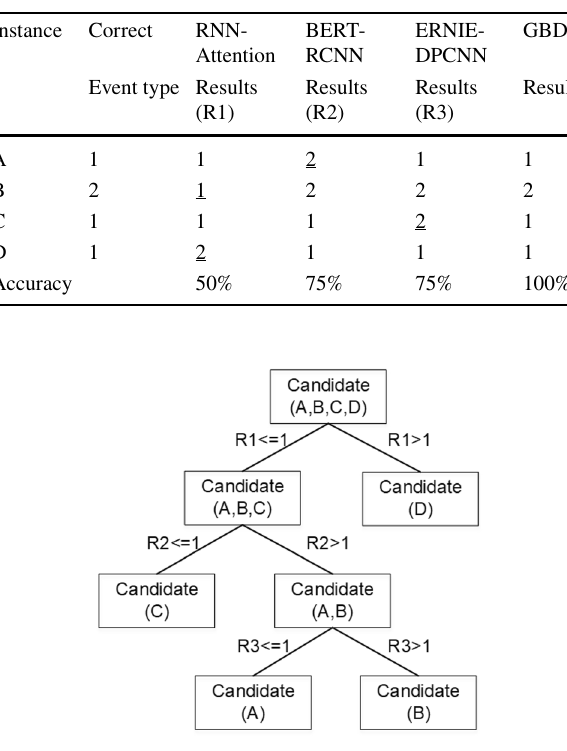
Fig. 6 Example of DT structure. The set in parentheses is the